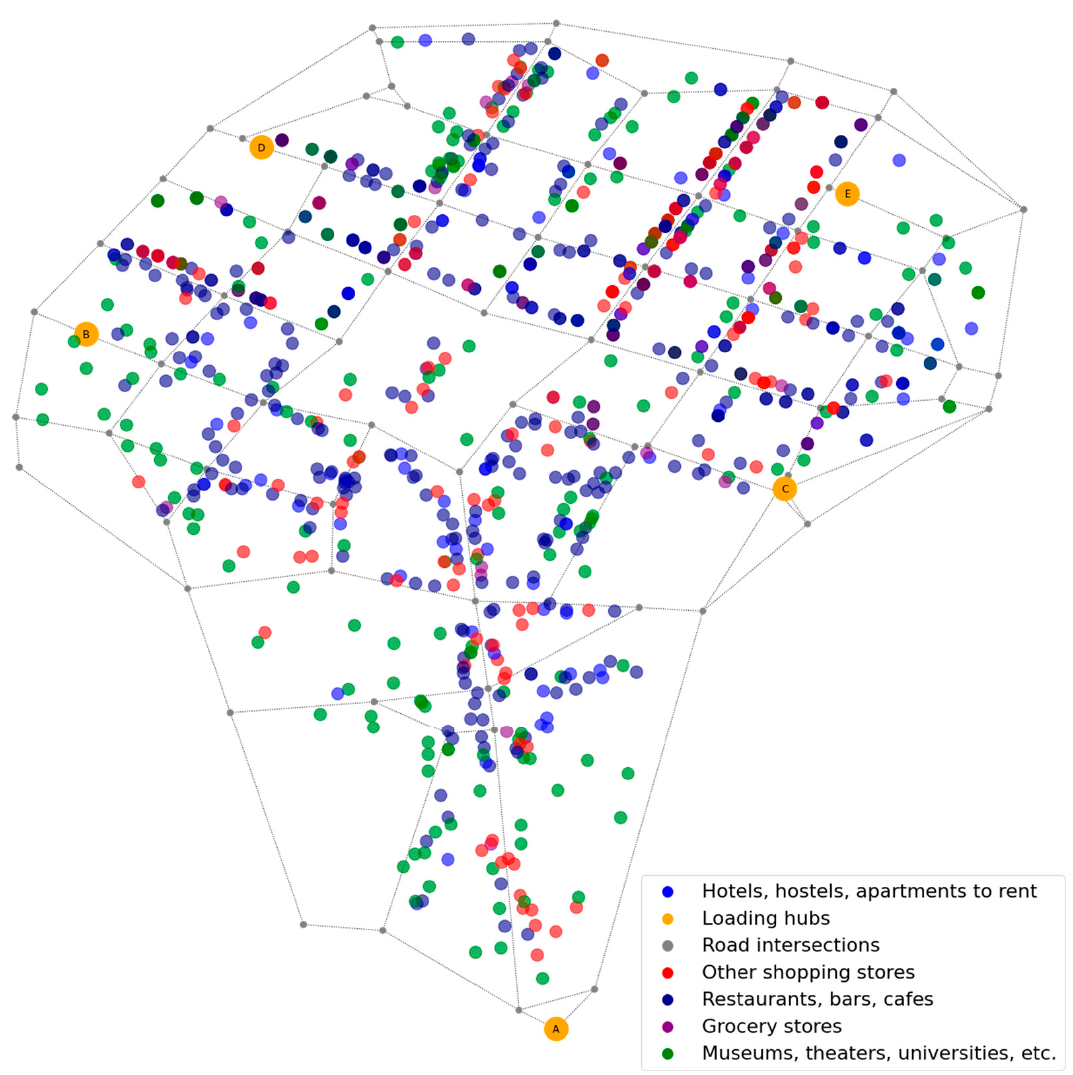
Figure 5. Locations of clients, intersections, and loading hubs in the Krakow Old Town.